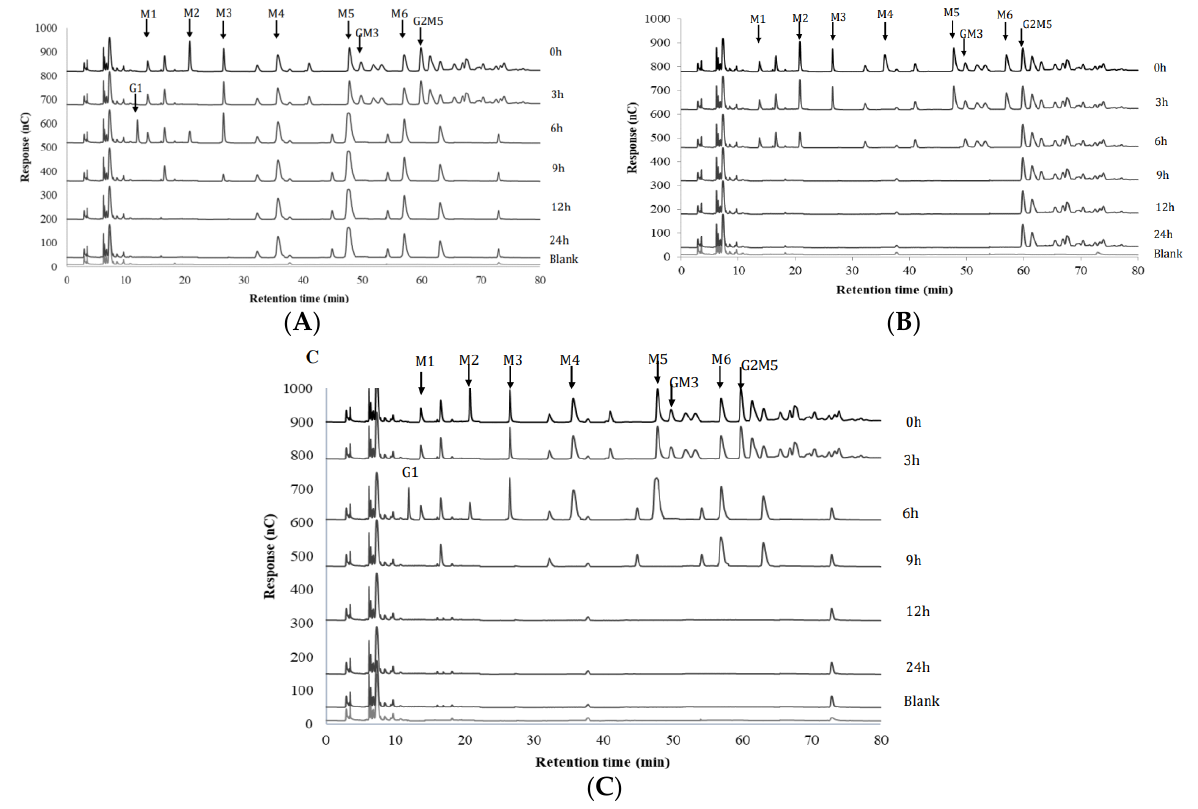
Figure 2. High-performance anion-exchange chromatography with pulsed amperometric detection (HPAEC – PAD) analysis of (galacto)- β -mannan-oligosaccharide (MOS/GMOS) utilization during the growth of ( A ) B. adolescentis , ( B ) R. hominis , ( C ) B. adolescentis , and R. hominis in coculture. The HPAEC–PAD analysis of the fermentation medium was carried out by using CarboPac PA200 column, as mentioned in Materials and Methods, in Section 2.11, Saccharide analysis by HPAEC– PAD. The elution was according to the previously described method optimized for fermentation media, as described previously in Bhattacharya et al. 2021 [16]. The arrows point to the retention time of galactose (G1), mannose (M1), linear mannan-oligosaccharides, MOS (mannobiose, M2, to mannohexaose, M6), and galactosylated mannan-oligosaccharides, GMOS (galactosyl mannotriose, GM3; di-glactosyl mannopentaose, G2M5) that have been used as standards in this study. All substrates were used at 5 g/L. An injection volume of 10 µ L was used for all